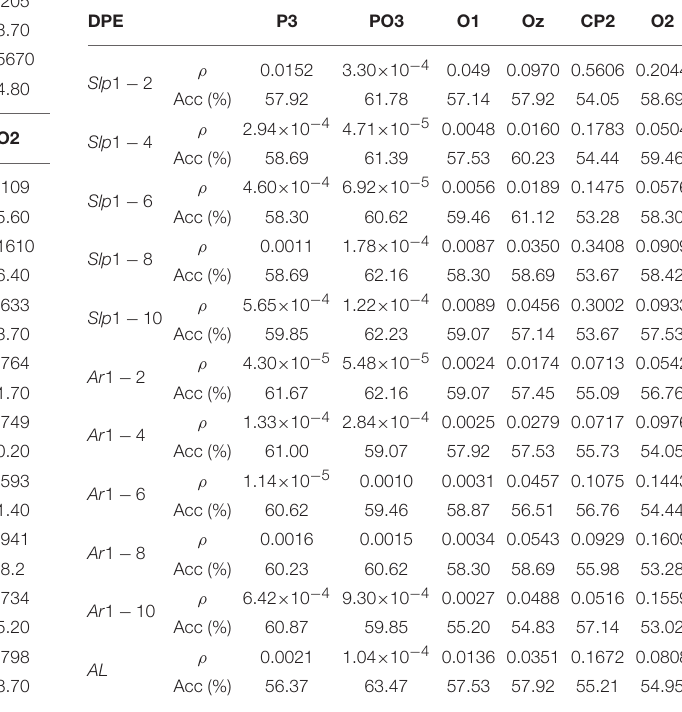
TABLE 2 | Results of ρ and Acc of the DPE curve-related